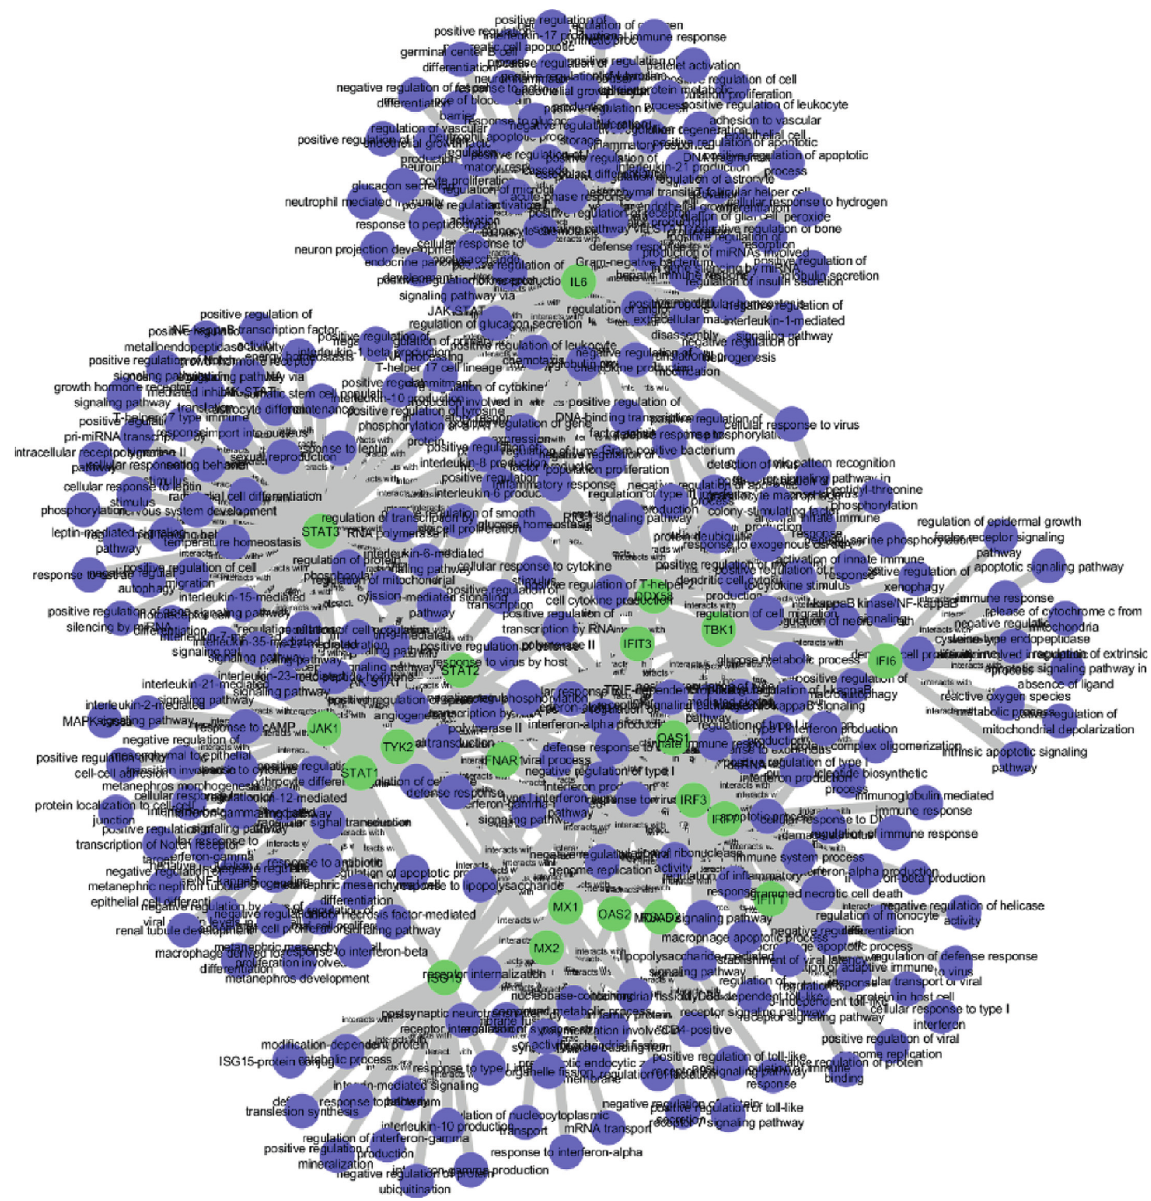
Figure 10: Bipartite graph of important protein-biological process. Table 1: Maximum number of clusters for each type of